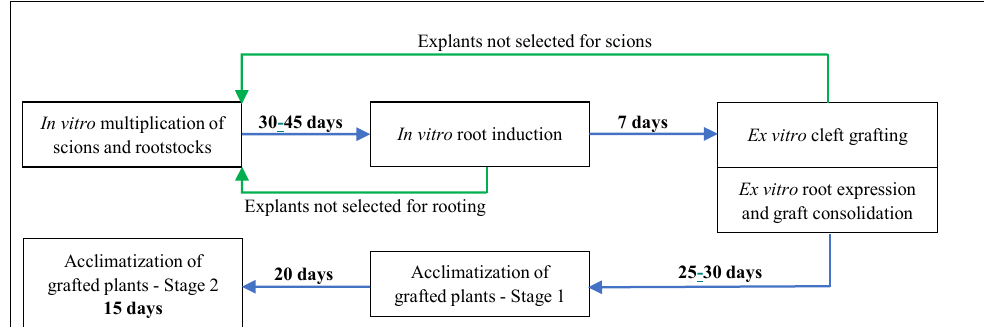
Figure 5. The different production phases of the grafted plants and the time needed for accomplishment of each phase. Scion and rootstock explants not selected return to the initial multiplication phase (green arrows). The all process for production of a grafted plant takes about 90 days.